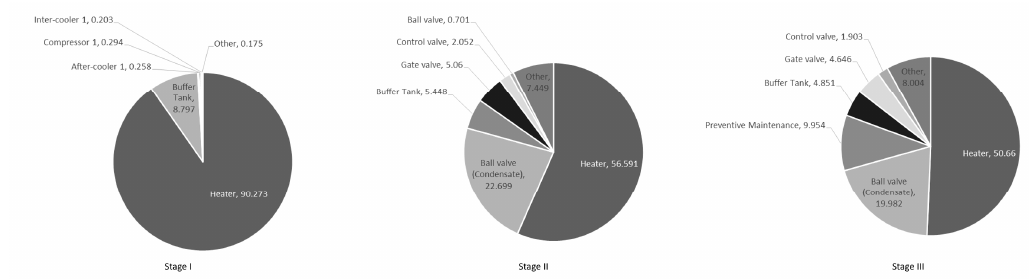
Figure 14. Component criticality depending on the stages.